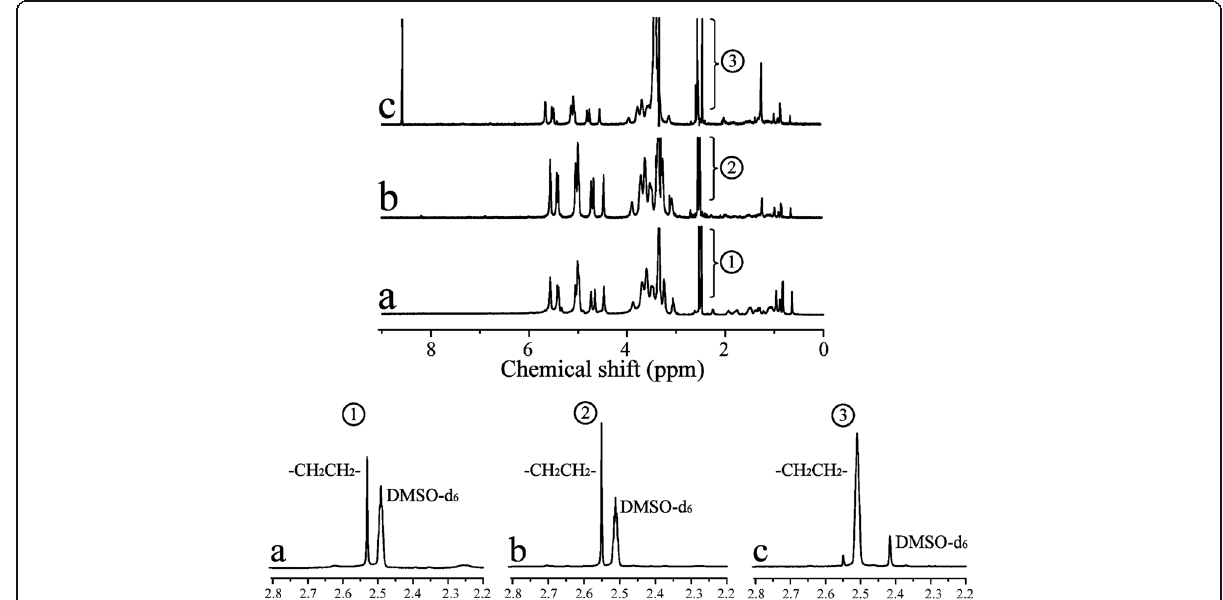
Fig. 3 1 HNMR spectra for CHP (a), CHSP (b), and CHAP (c)